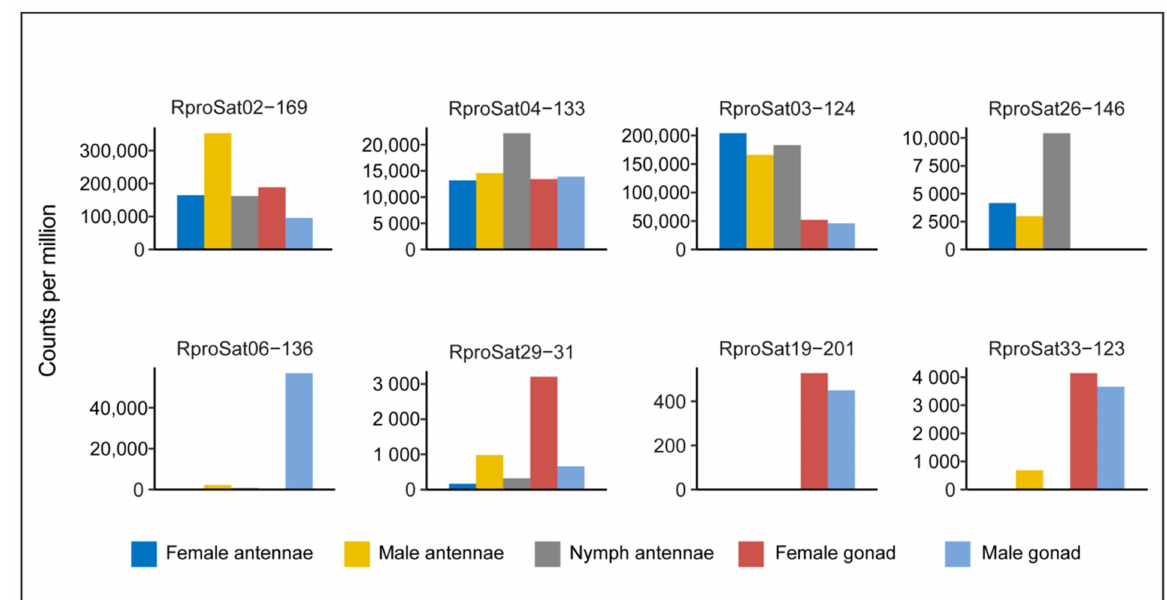
Figure 7. Examples of the four transcription patterns shown by satDNA families of R. prolixus in different